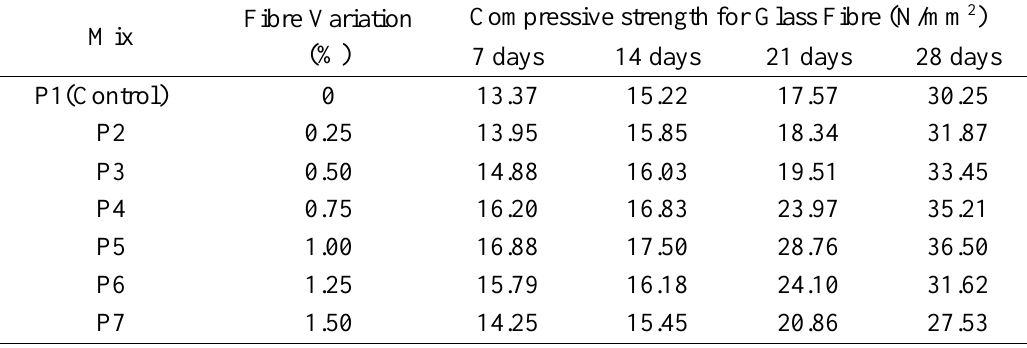
Table 3. Compressive strength for glass fibre